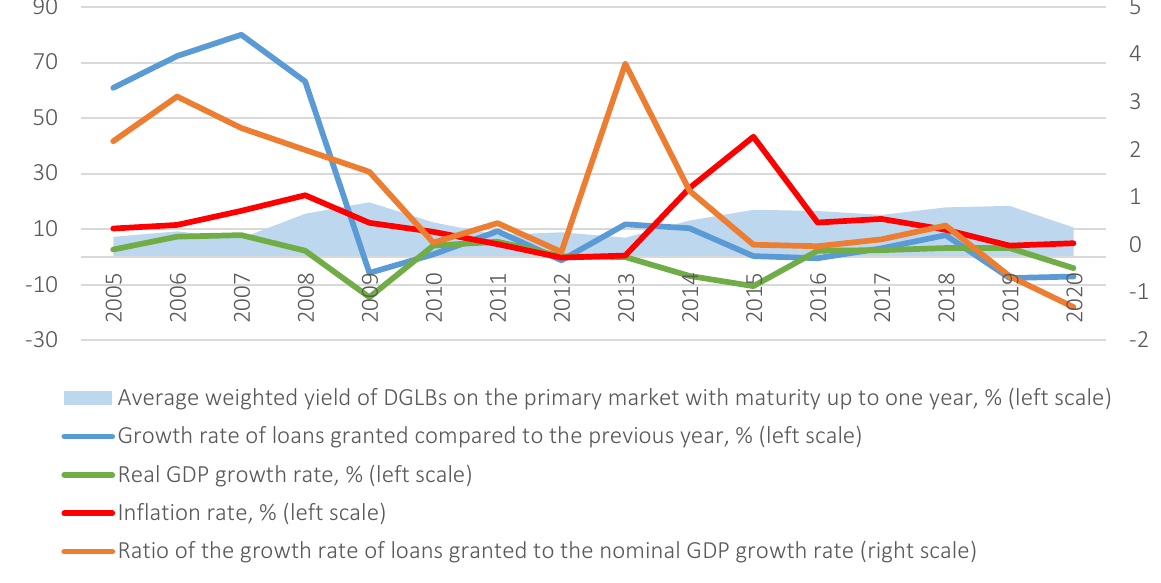
Figure 7. Values of indicators characterizing the features of the MTM credit